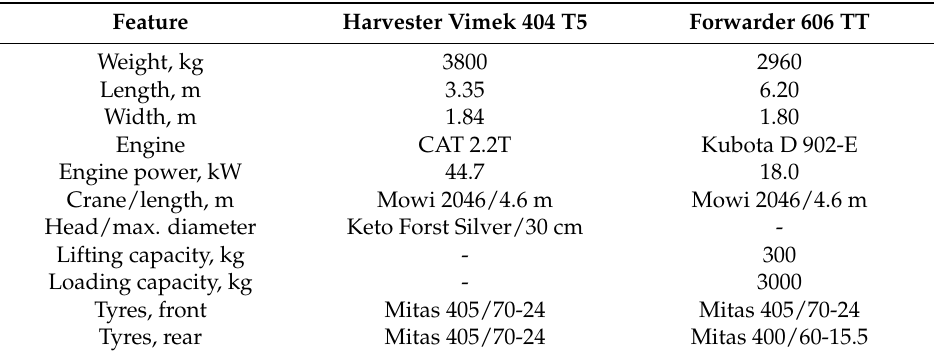
Table 3. Harvester and forwarder